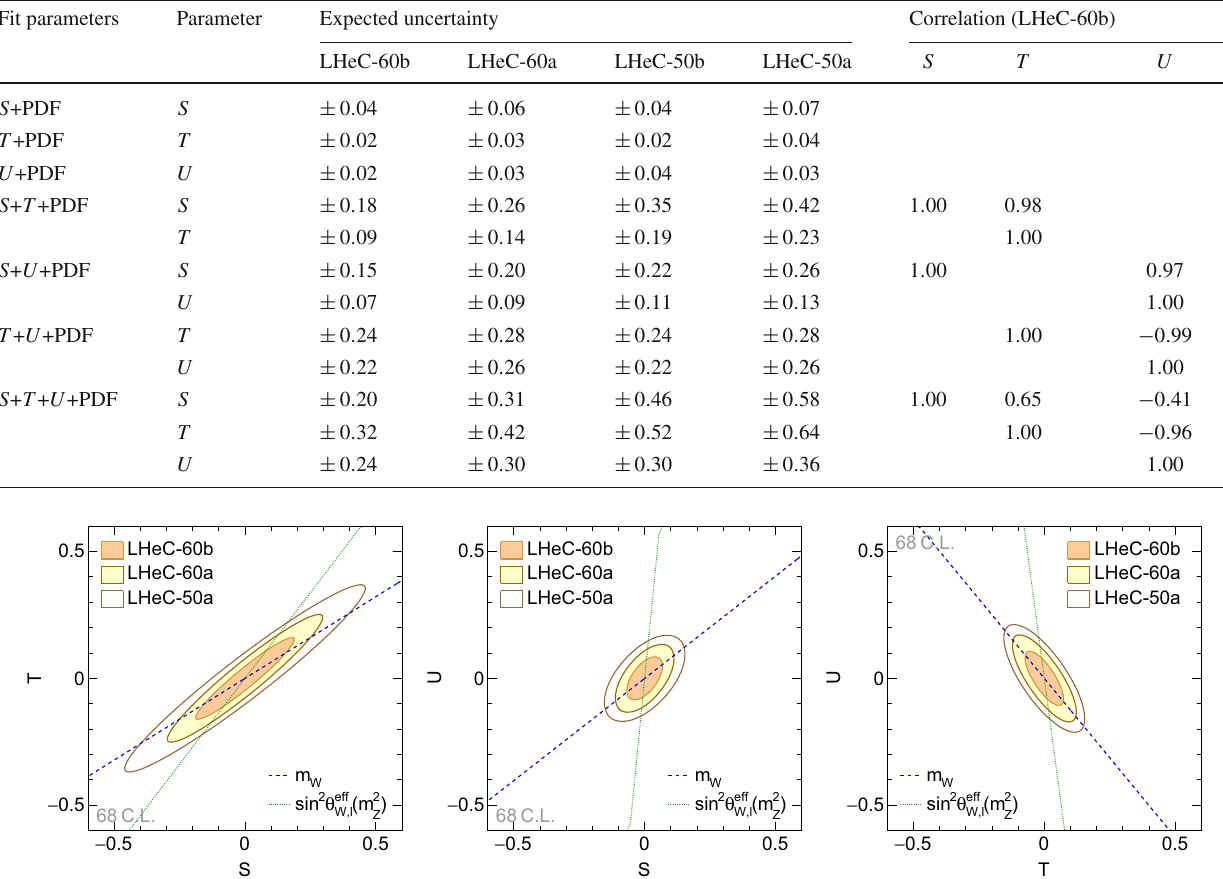
Table 5 Results of the STU +PDF fits with fixed SM gauge boson masses. From top to bottom we show the expected uncertainties for 1-, 2- and 3-parameter fits as indicated in the first column for all four LHeC